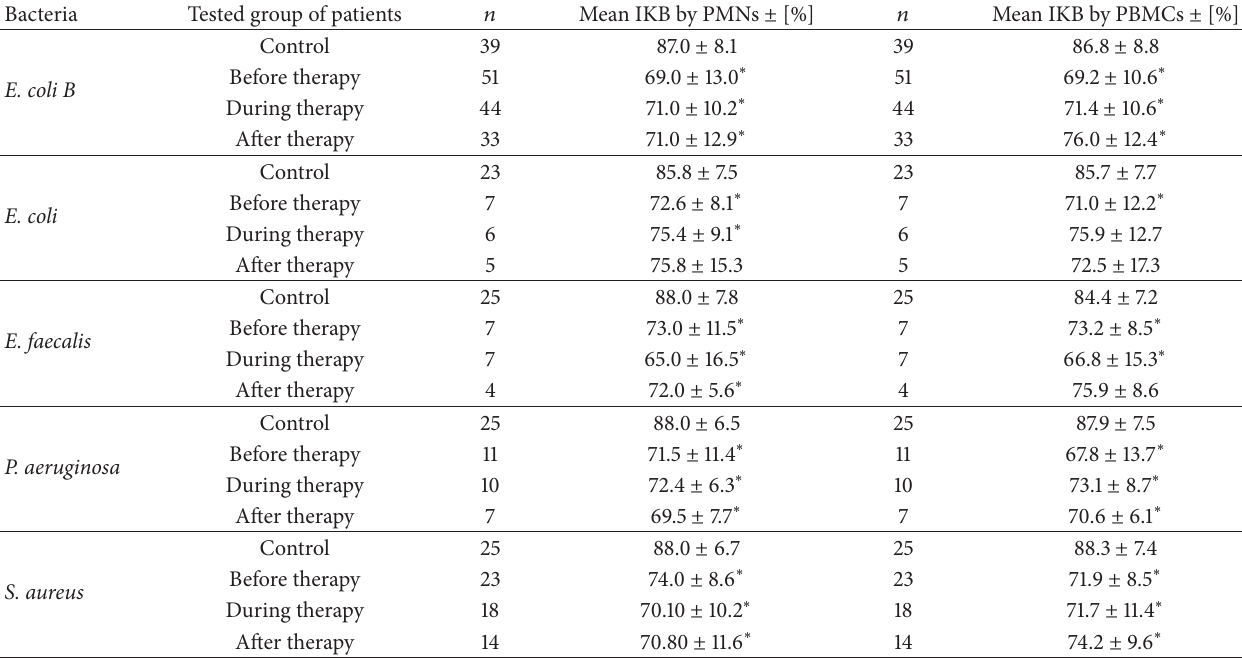
Table 1: Intracellular killing of nonpathogenic and pathogenic strains compared to control. Bacteria